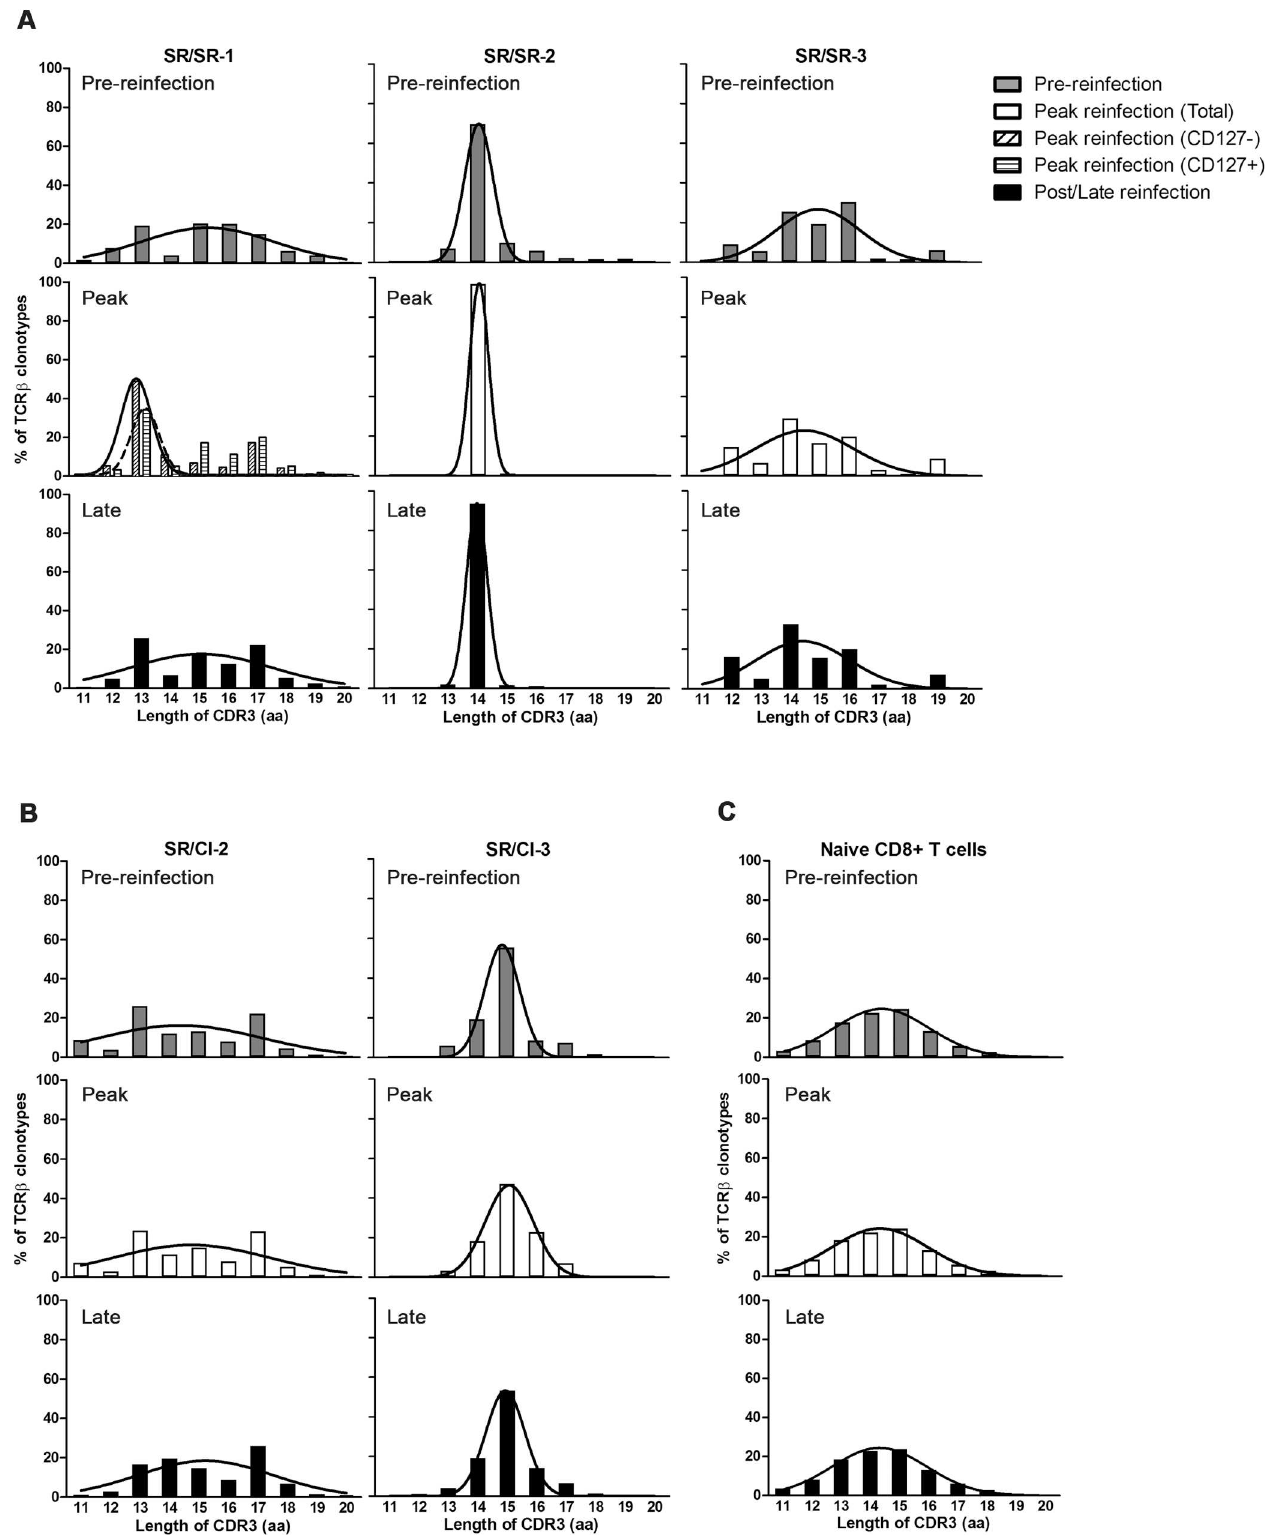
Fig 5. CDR3-length distribution for epitope-specific CD8 T cell repertoire in SR/SR patients as compared to SR/CI patients. Distributionof the CDR3 amino acid (aa) lengthsfrequenciesfor the clonotypesforming the epitope-specific CD8 T cell repertoirefor (A) three SR/SR